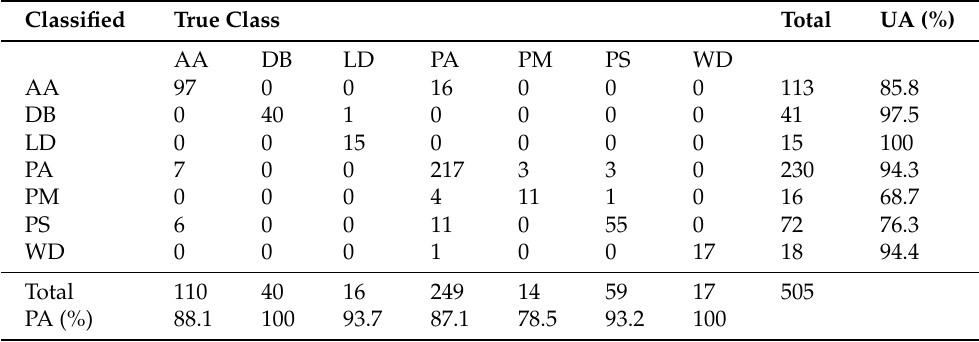
Table 8. Confusion matrix of the qualitatively validated 505 trees in the six validation sites; OA: 89.5% and Kappa coefficient ( κ ):